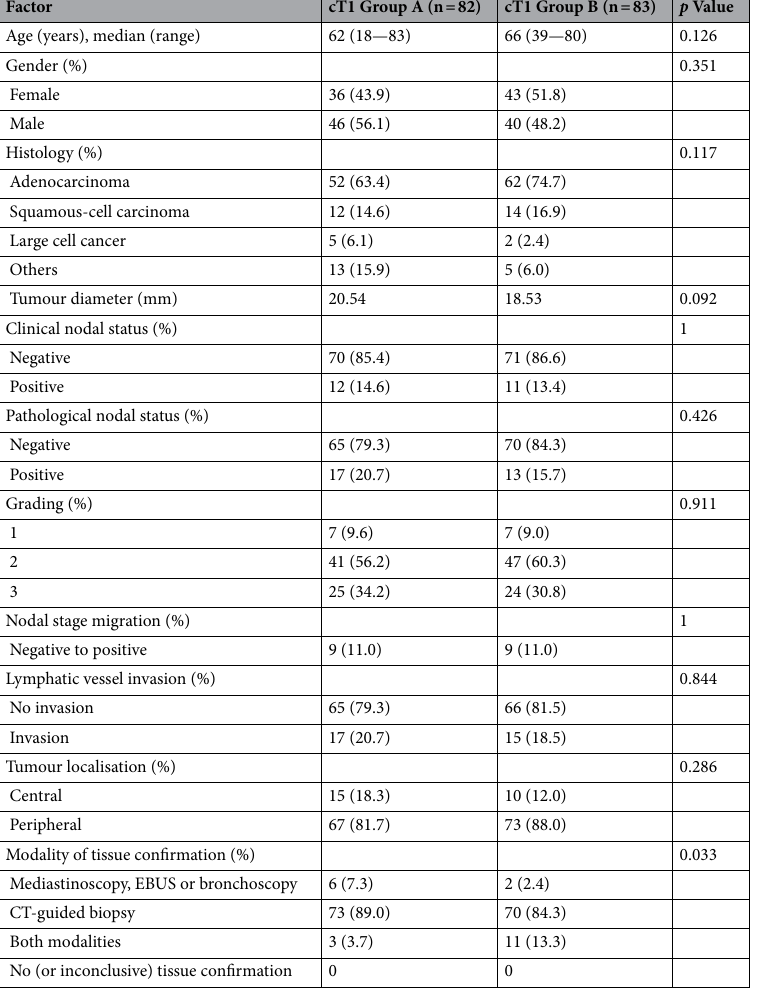
Table 2. Patients´ characteristics – cT1